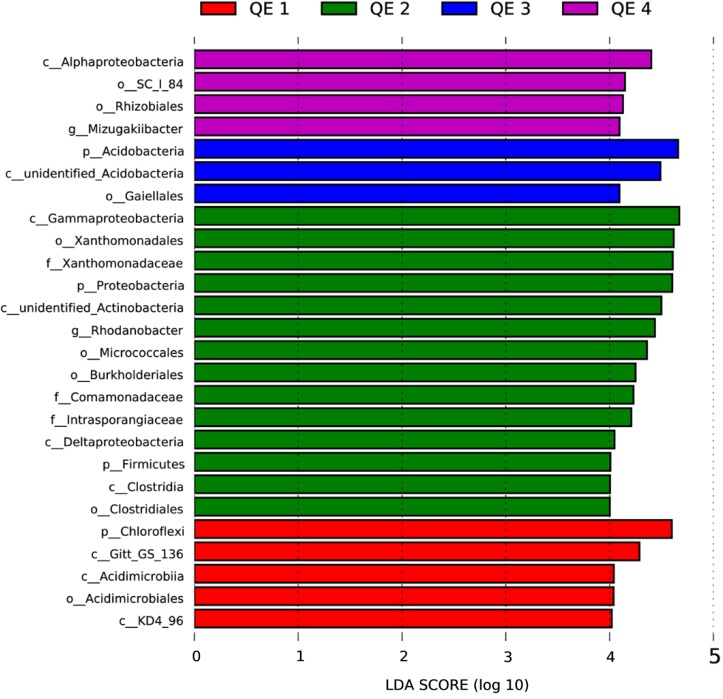
The LDA score distribution histogram is to search for Biomarker (Segata et al., 2011), which has a statistically significant difference between group and group, at all classification levels, and used the LDA score distribution histogram to show the species with LDA score larger than 4 in the present study.